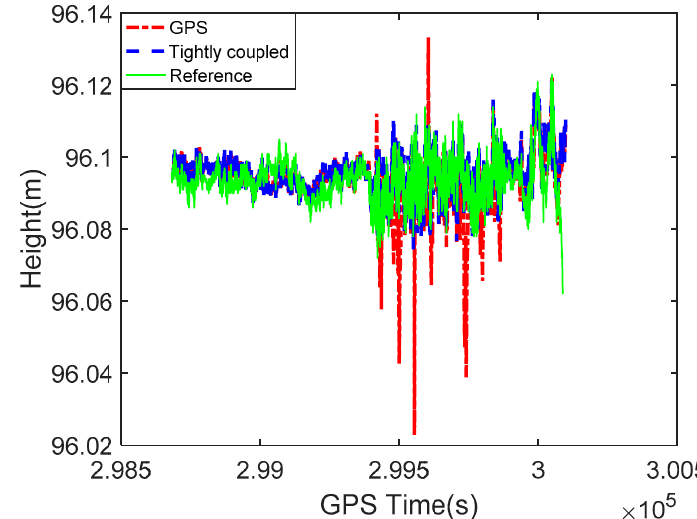
Figure 5. The height of the three results.